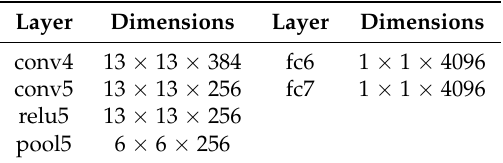
Figure 2. An example of scene and extracted features from different layers of the caffe-alex network. Features obtained from different ConvNet layers can serve as holistic image descriptors for place recognition. Table 1. The layers from the caffe-alex ConvNet model used in our evaluation and their output dimensionality (height × width × feature map